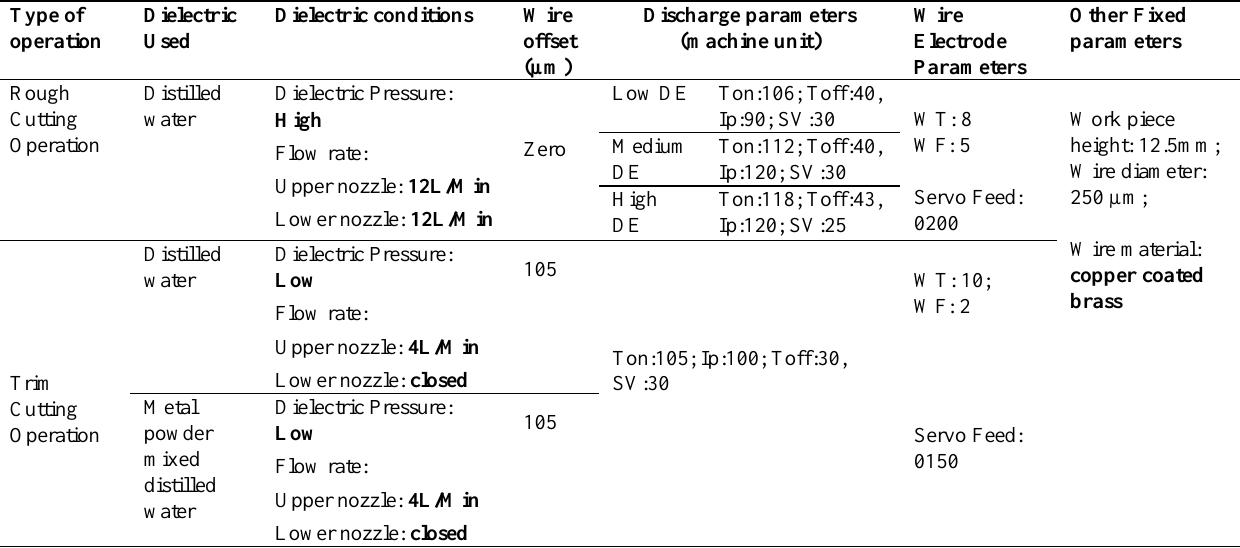
Parameters setting for rough and trim cutting